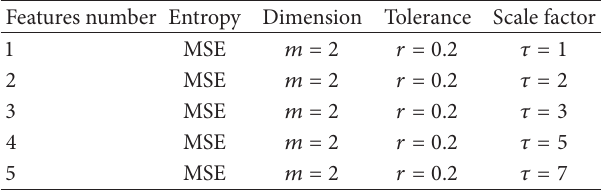
Table 4: Entropy features selection using MI algorithm.